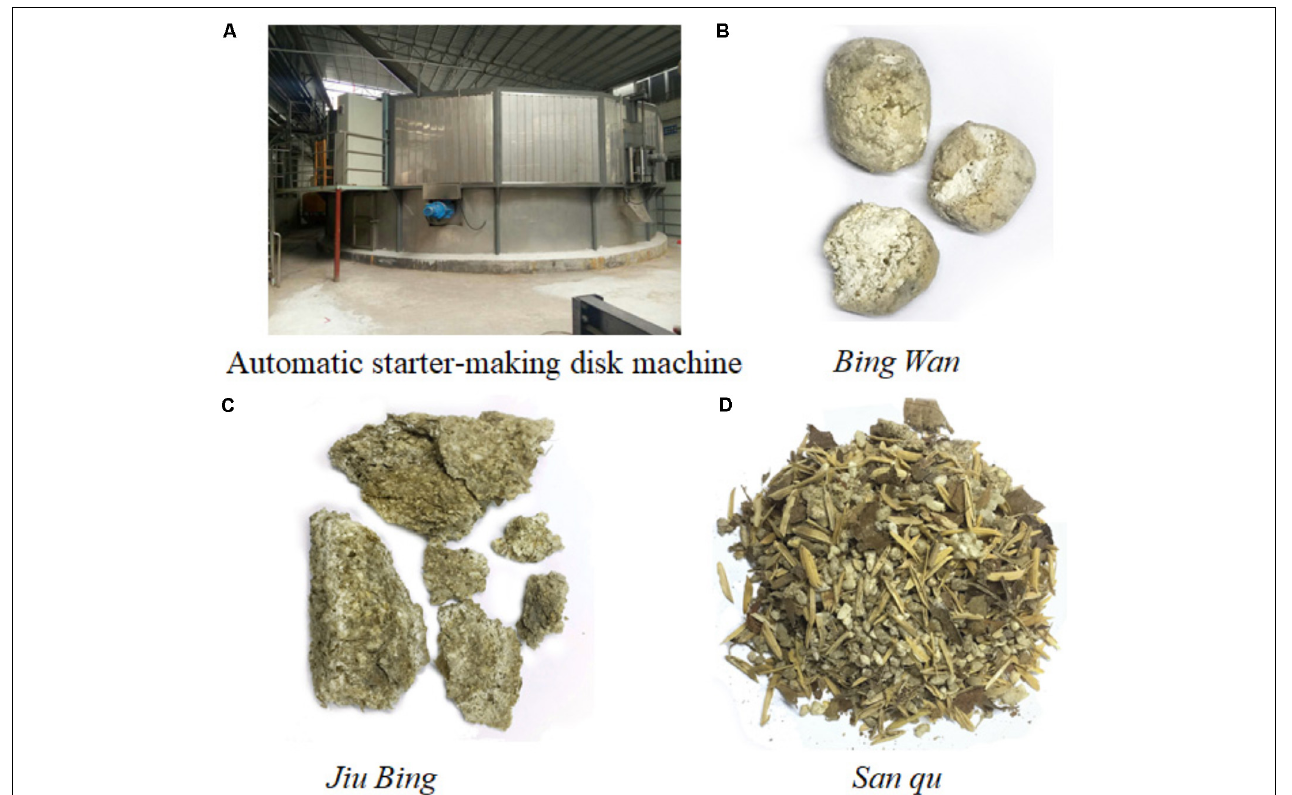
FIGURE 1 | The shapes of three different types of starters and the diagram of the automatic starter-making disk machine. (A) Automatic starter-making disk machine. (B) Bing Wan . (C) Jiu Bing . (D) San qu .